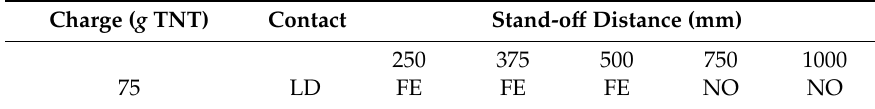
Figure 16. Tripod holding a charge (on the left) and simultaneous explosion over individual plates (on the right). Table 18. Response of ultra-high-performance fibre-reinforced cement-based composites (UHPFRCC) plates to blast loads of 75 g of TNT.